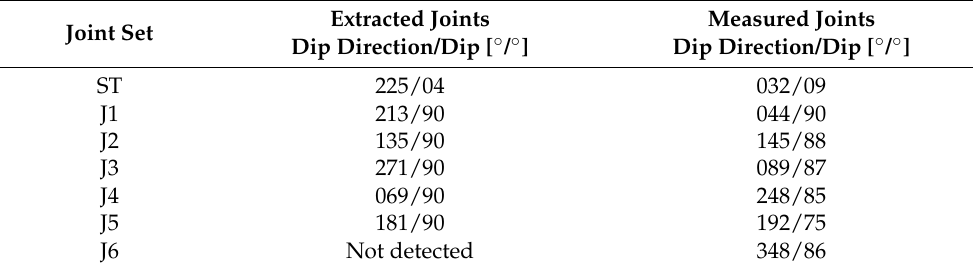
Figure 12. Pole plots of extracted joint sets for different values of the controlling parameters embedded in DSE: ( a ) knn = 20 and Angle min v ppal = 20; ( b ) knn = 10 and Angle min v ppal = 10; ( c ) knn = 5 and Angle min v ppal = 20. ( d ) Stereoplot of joint orientation measurements acquired with the traditional geological compass. Table 8. Average orientation data of extracted and measured discontinuity sets.